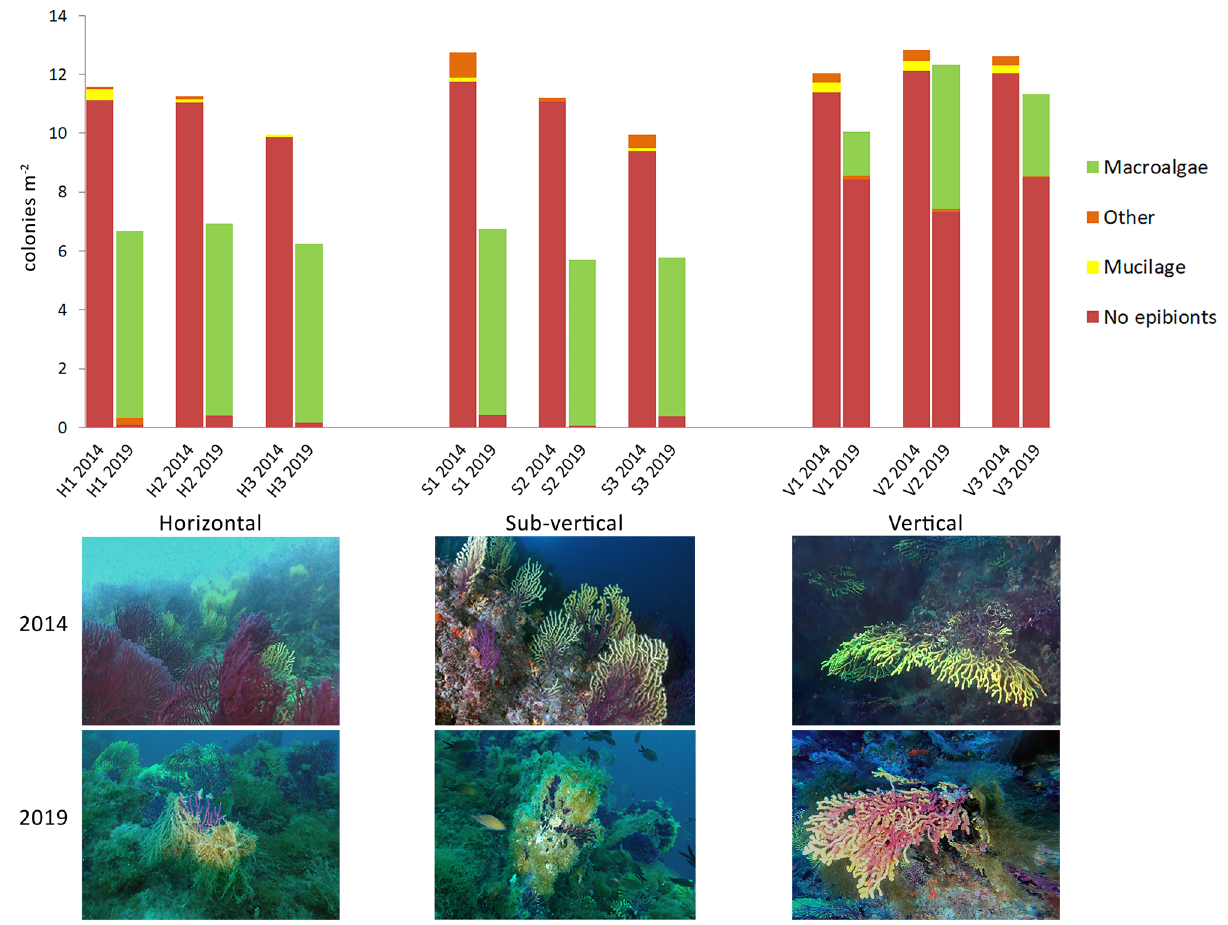
Figure 4. Colonies density of Paramuricea clavata on the three portions of the shoal, with three different inclinations of the seabed, surveyed during 2014 and 2019 (three study sites each). Densities of the colonies affected by mucilage and epibionts are provided, with representative photos of the same portions on the shoal during both 2014 and 2019